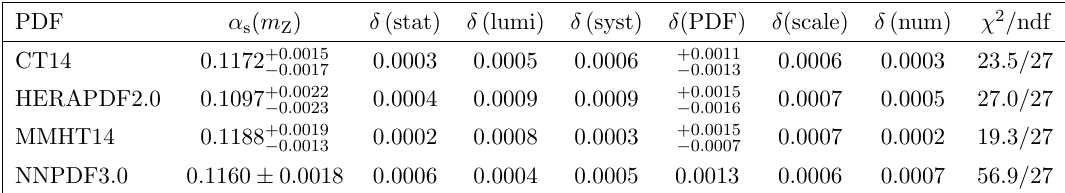
Table 13 . Strong coupling constant (cid:11) s ( m Z ) values extracted per PDF set by combining all the individual results obtained for each W (cid:6) and Z boson production cross section measurements (ta- bles 15 and 16), listed along with their propagated total and individual uncertainties. The last column tabulates the goodness-of-(cid:12)t per degree of freedom (cid:31) 2 /ndf of the (cid:12)nal single combined result compared to the 28 individual (cid:11) s ( m Z )